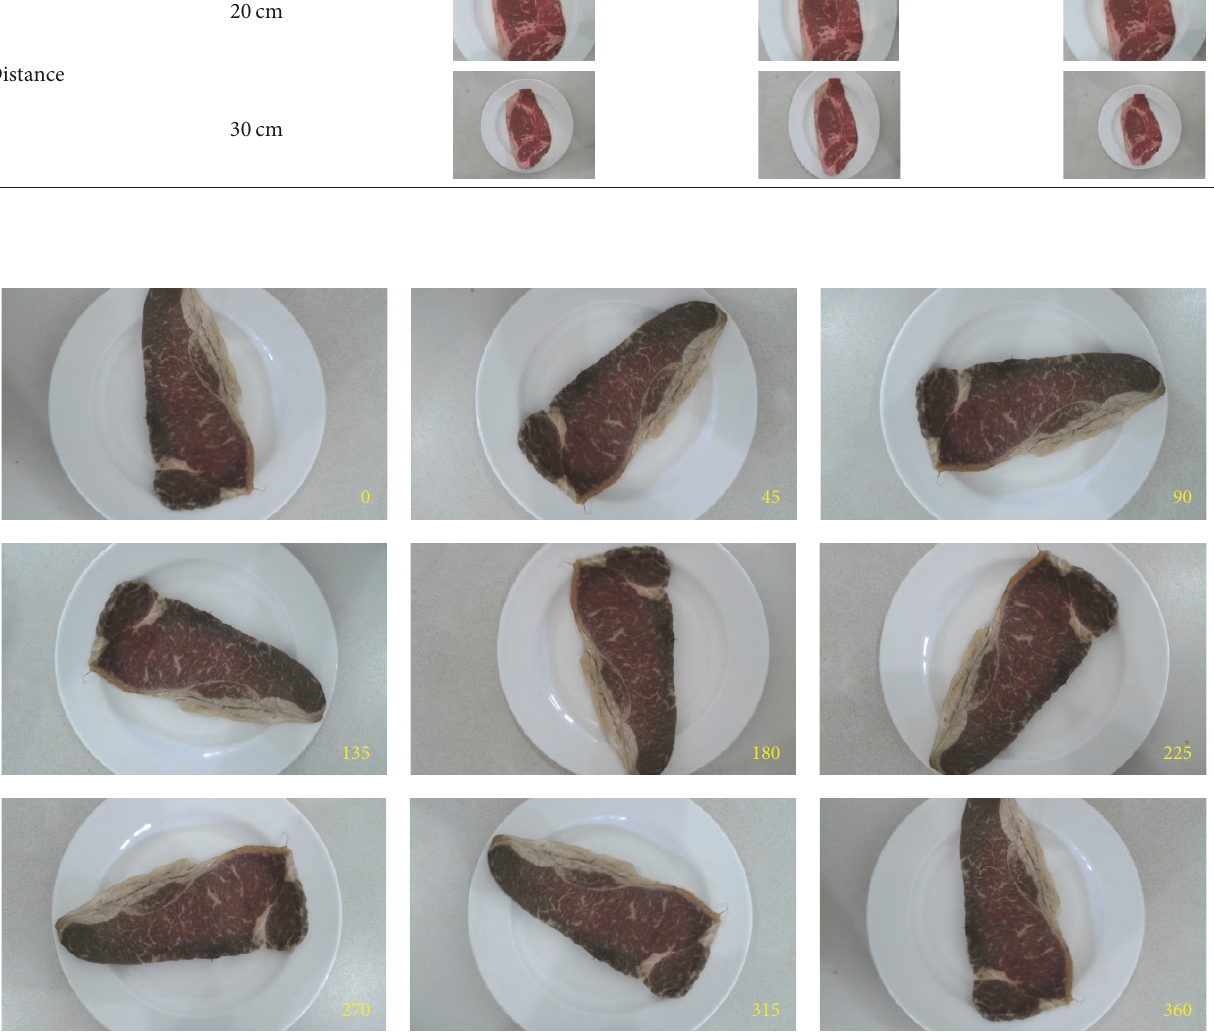
Figure 4: Samples of beef image with variation of camera